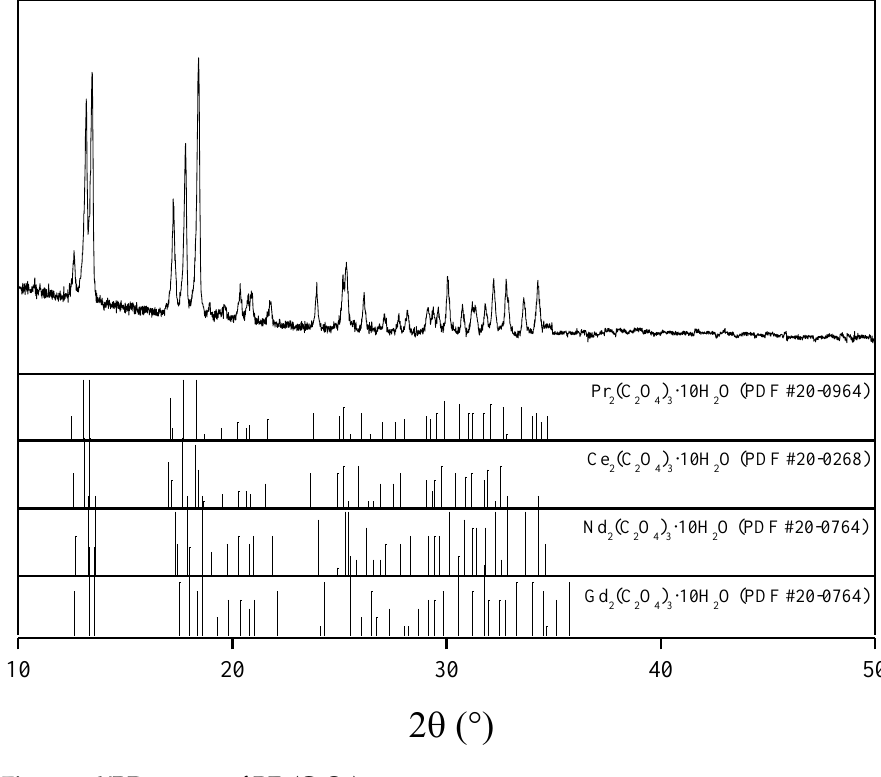
Figure 3. XRD pattern of RE 2 (C 2 O 4 ) 3 .